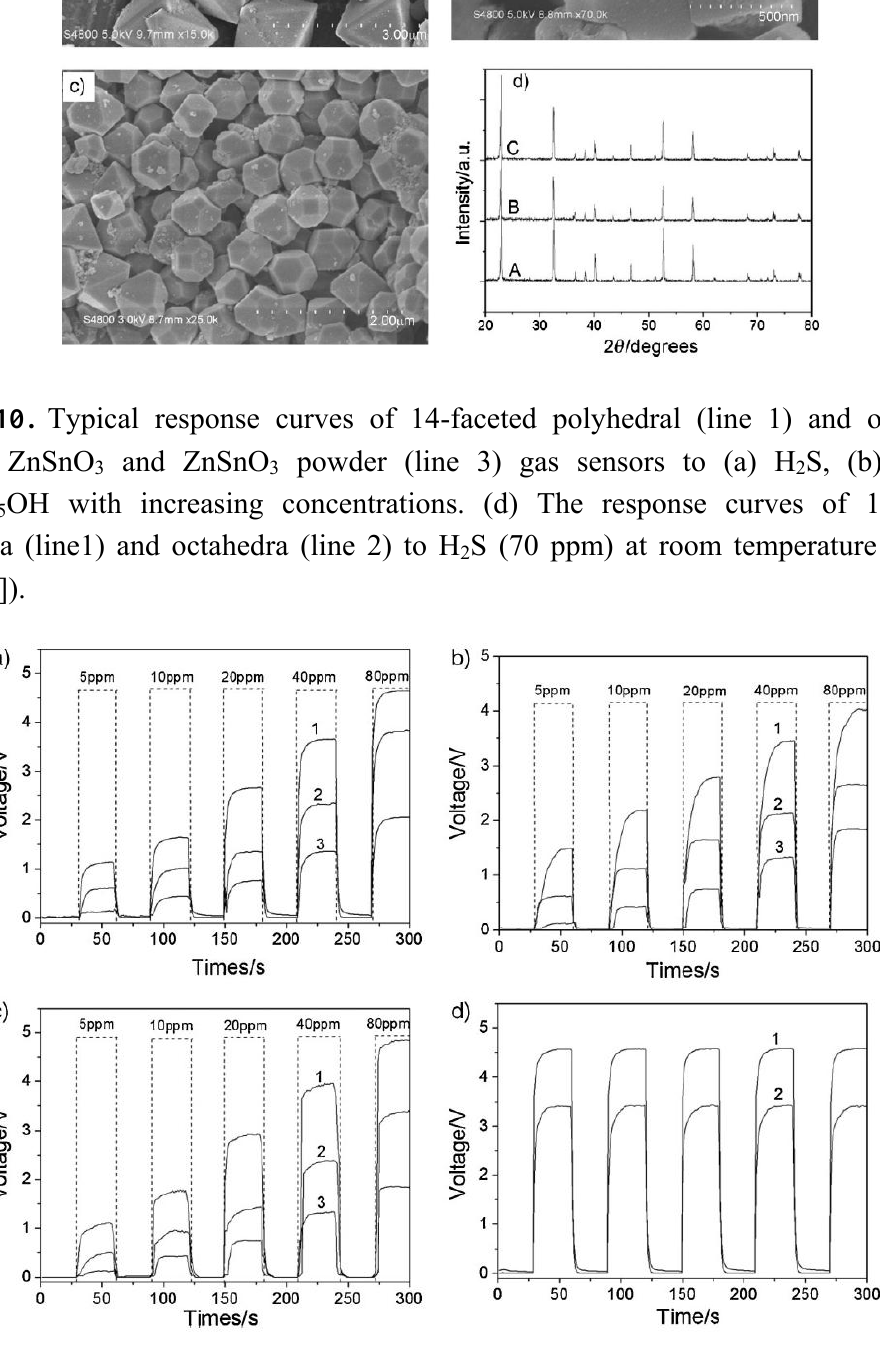
Figure 9. Typical SEM images of the as-prepared ZnSnO products: (a) CTAB = 0.15 M; 3 (b) CTAB = 0.4 M; (c) CTAB = 0.75 M. (d) The corresponding XRD patterns of the polyhedra, A: octahedra; B: truncated octahedra; C: 14-faceted as-prepared ZnSnO 3 polyhedra (adapted from [60]).